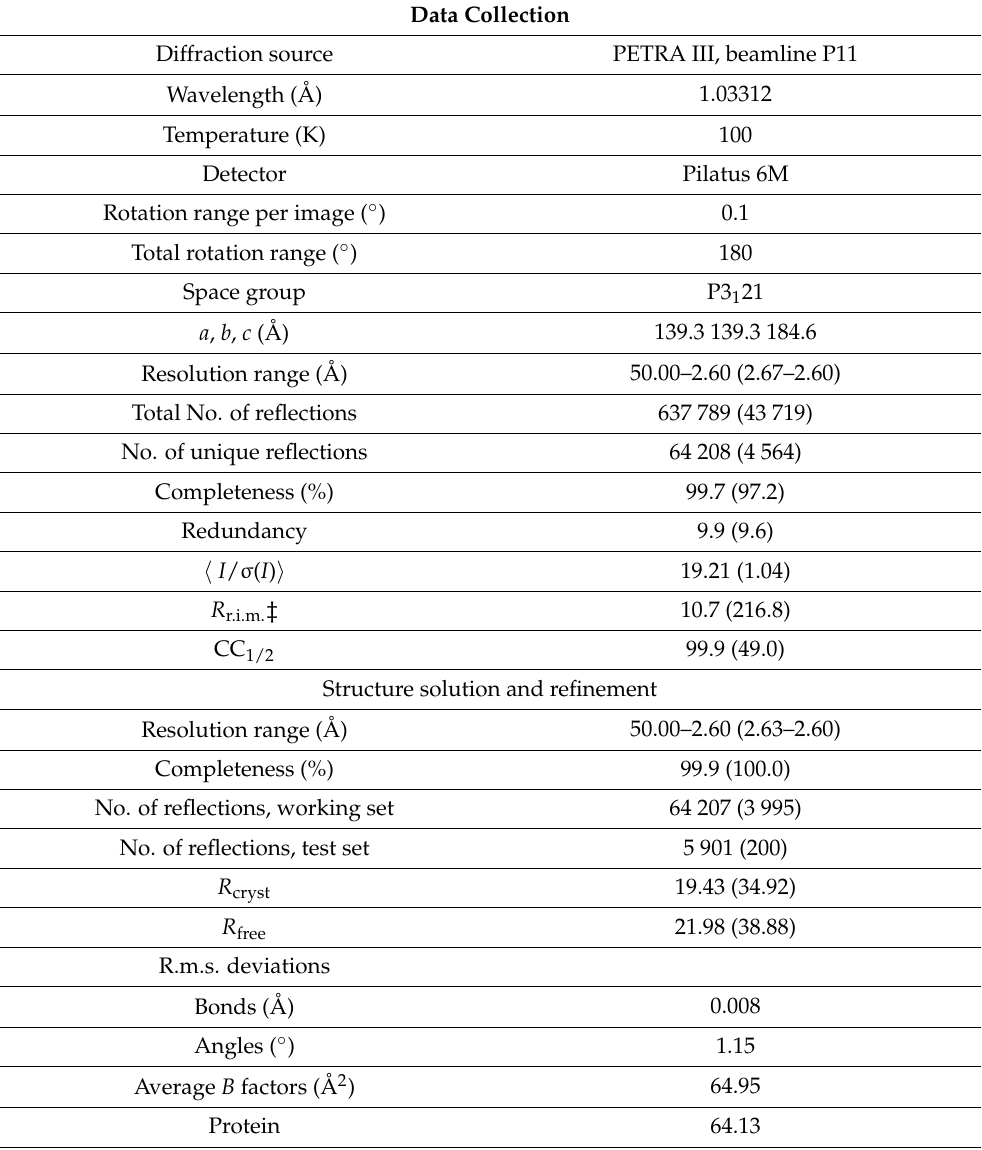
Table 1. Data collection and